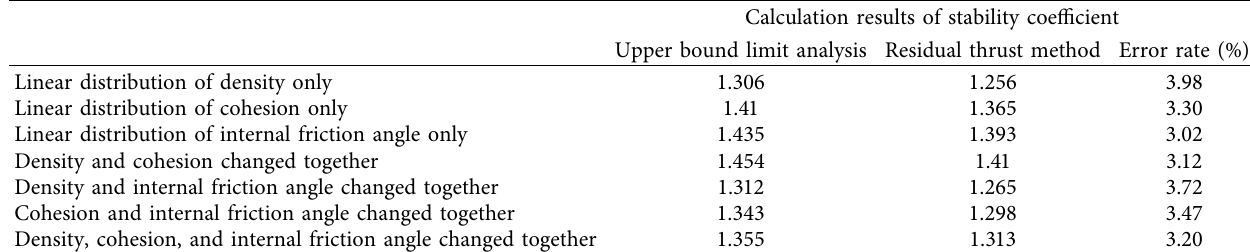
Table 1: Calculation results of the slope stability coefficient with upper bound limit analysis and the residual thrust method.